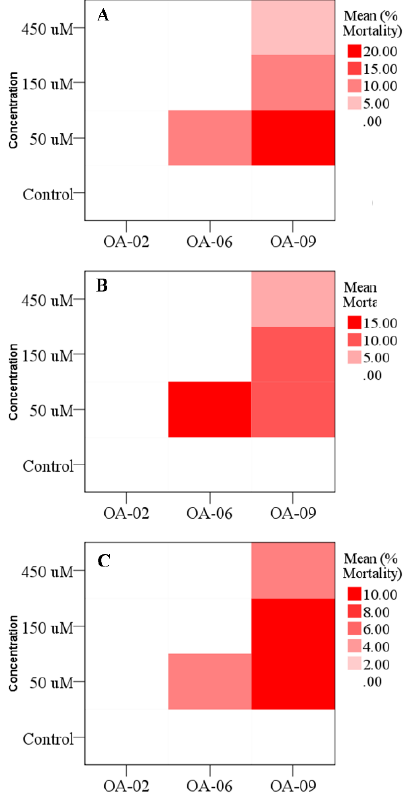
Figure 3. Mean mortality percentages of ( A ) 3rd instar (Compound: H = 6.33; df = 2; p = 0.042 and Concentration: H = 9.30; df = 2; p = 0.026), ( B ) 4th instar (Compound: H = 4.31; df = 2; p = 0.116 and Concentration: H = 5.91; df = 2; p = 0.116) and ( C ) 5th instar larvae (Compound: H = 3.75; df = 2; p = 0.056 and Concentration: H = 2.114; df = 2; p = 0.486) of Helicoverpa armigera when treated with different concentrations of OA-02, OA-06 and OA-09 compounds. The data were subjected to nonparametric Kruskal–Wallis H Table 3. LC50 and LC90 values of OA-02, OA-06 and OA-09 compounds against H. armigera larvae along with their probit model fit parameters.